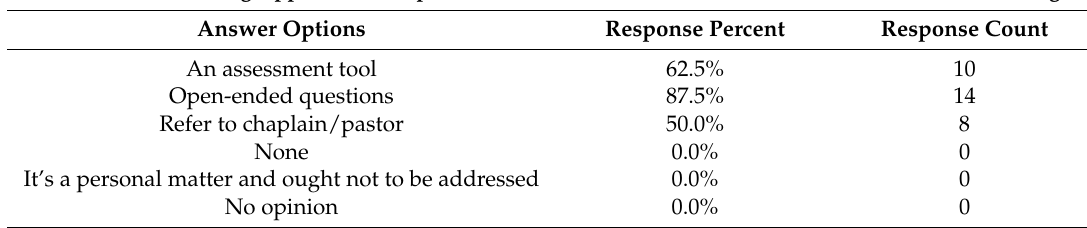
Table 9. Views on approaches to spiritual assessment recommended in healthcare